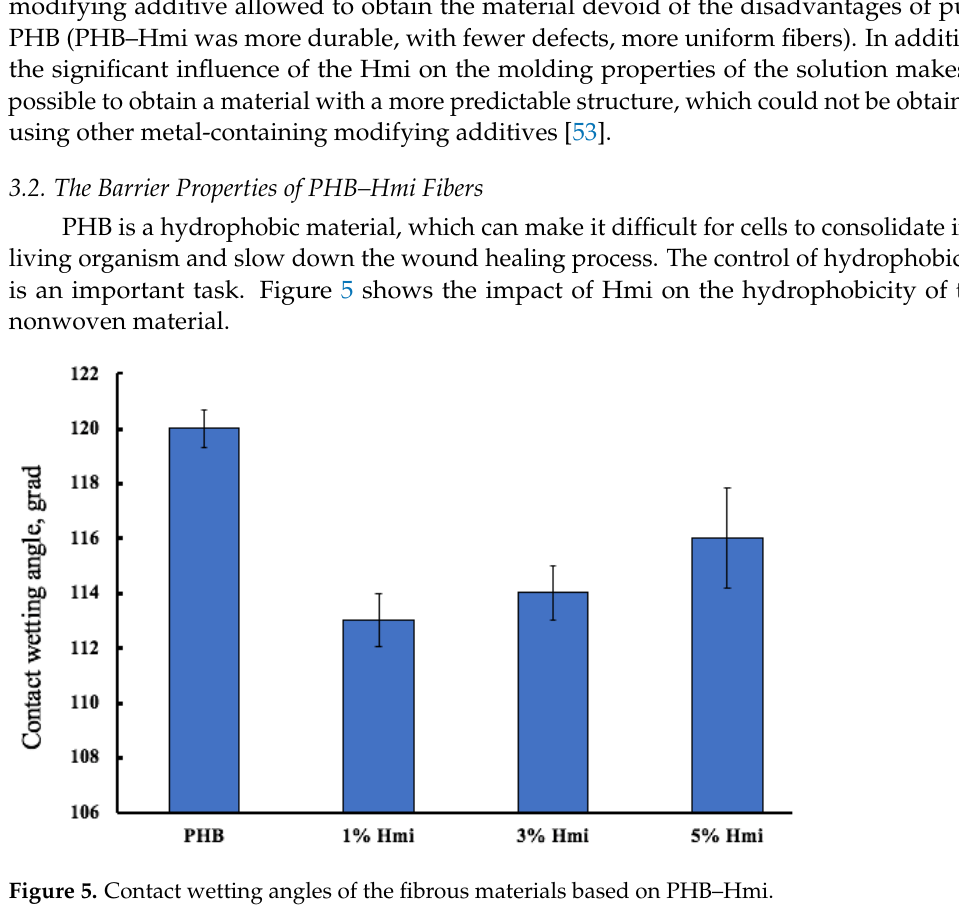
Figure 6. Air volume that passed through the fibrous materials based on PHB – Hmi according to the Gurley method. The key parameter affecting the permeability of the nanofibrous material is the mor- phology of the fibrous layer. With an increase in porosity and with a decrease in the num- ber of glues and engagements, the material becomes more accessible for air transfer. Air permeability control is extremely important for the formation of a reliable environment in the wound healing zone. Thus, we observed five-fold air permeability increment with the addition of 5% of Hmi.